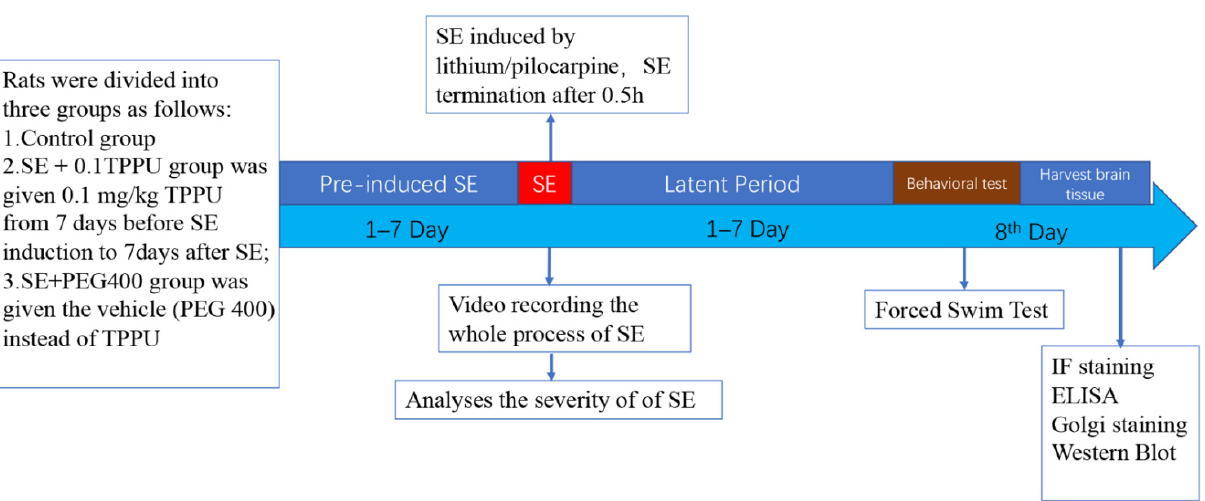
Figure 1. Schematic illustration of the protocol used in the experiment. TPPU or vehicle treatment paradigm: TPPU or vehicle was given intra-gastrically from 7 days before SE induction to 7 days after SE, and the forced swim test was performed on the 8th day after TPPU treatment. SE, status epilepticus; TPPU, 1-trifluoromethoxyphenyl-3-(1-propionylpiperidin-4-yl) urea; IF, immunofluorescent; ELISA, enzyme-linked immunosorbent assay.